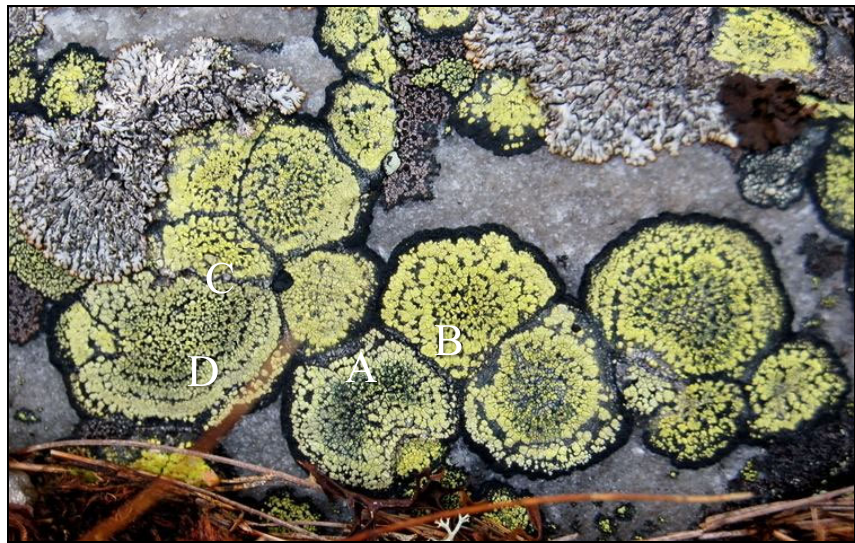
Figure 1. Differing growth rates can be deduced from the shape of thalli perimeters in contact with others: ( A ) a small thallus showing a convex margin where it meets a larger thallus is in its rapid growth period; ( B ) a straight ‐ line margin indicates equal growth rates. ( C ) Competition leading to thalline margins becoming less distinct and ( D ) a large thallus partially surrounded by smaller thalli. (Photo, with permission Arnstein Rønning).